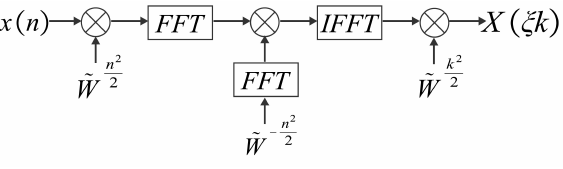
Figure 4. The calculation process of CZT using